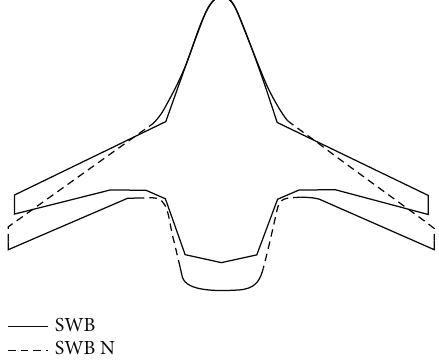
SWB SWB N Figure 12: The basic shape of SWB and SWB